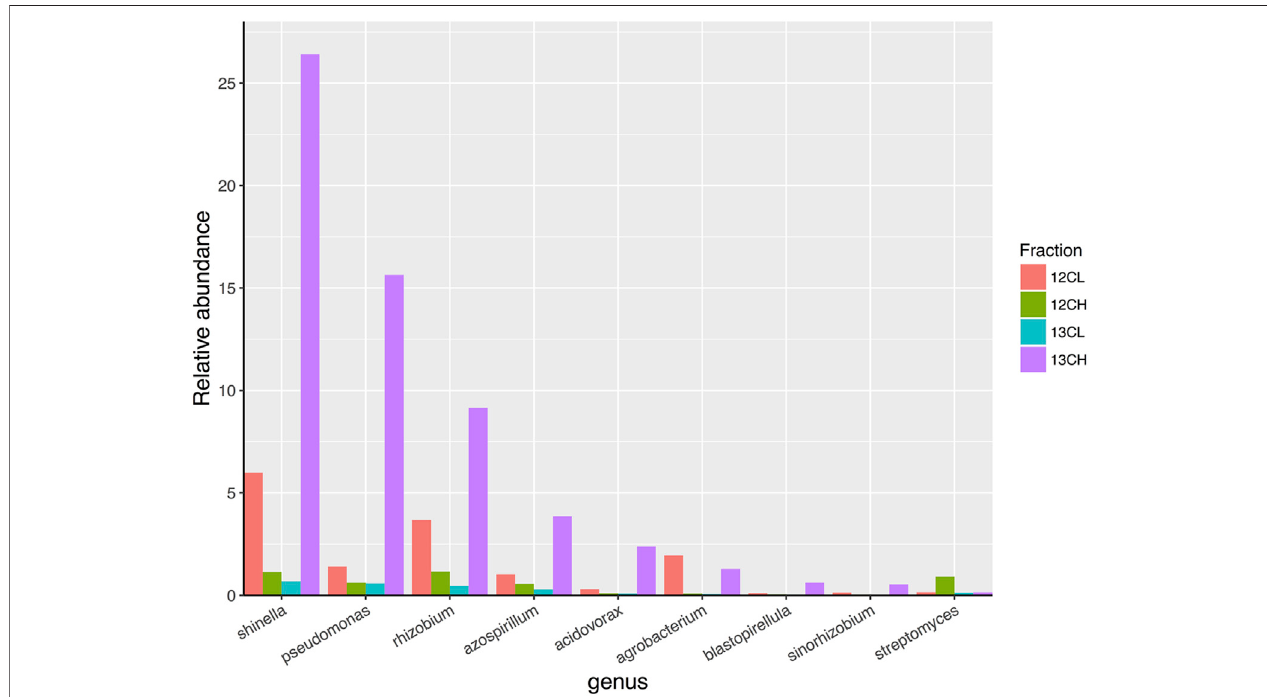
FIGURE6| Therelative abundance ofeight generaofbacteriathatdemonstrated thegreatest overallenrichmentbetween the 13 CH fraction and the 12 CH fraction due to the metabolism of 13 C labeled root exudates in the endophytic compartment of Arabidopsis thaliana plants. In comparison, the genus Streptomyces did not demonstrate enrichment between these fractions suggesting they did not metabolize 13 C-labelled root exudates. 12CL/13CL and 12CH/13CH are the buoyant density fractions representing the light/unlabelled (L) and heavy/labeled (H) fractions of DNA from 12 CO 2 (12C) or 13 CO 2 (13C) incubated plants,